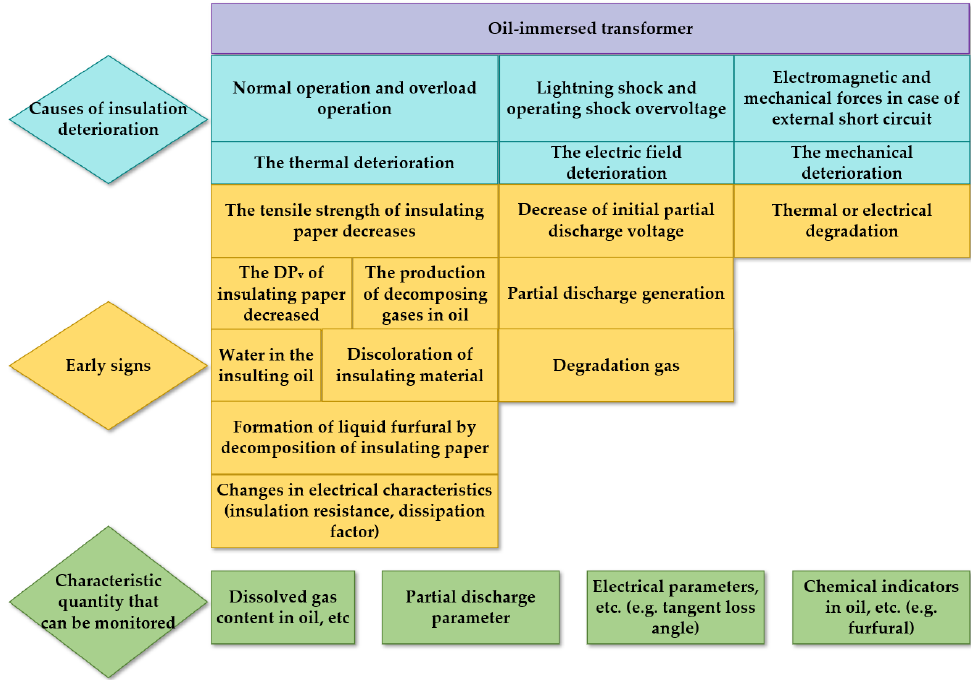
Figure 2. Oil-paper insulation aging factors and their early signal and monitoring indicators.